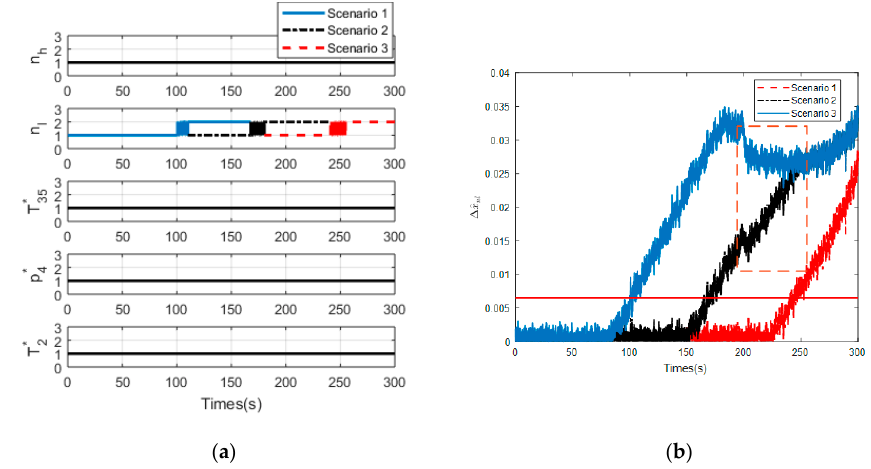
Figure 7. Three scenarios of 𝑛 (cid:3039) drifting fault of ( a ) FDI scheme and ( b ) fault estimation scheme.